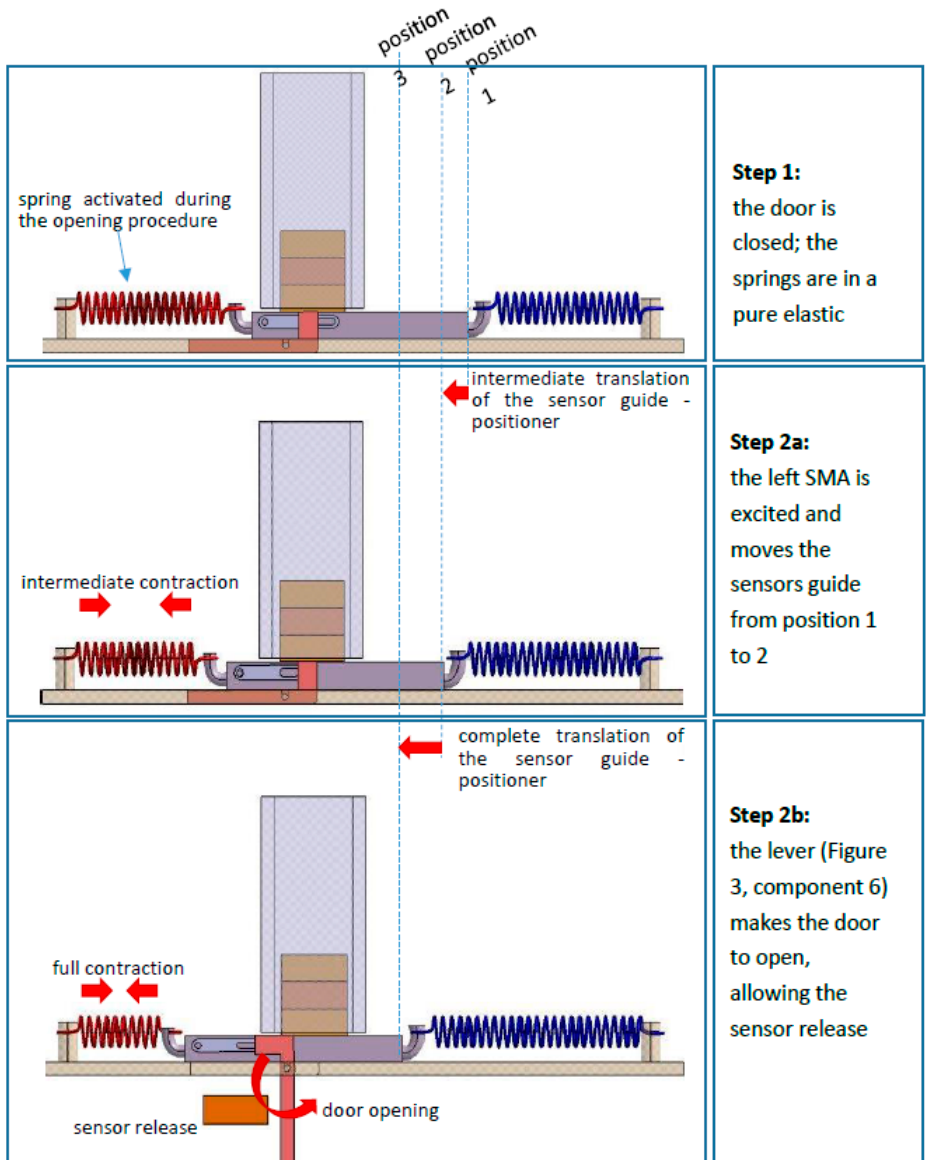
Figure 6. ESS working principle schematic, highlighting the main phases of the sensor’s release.